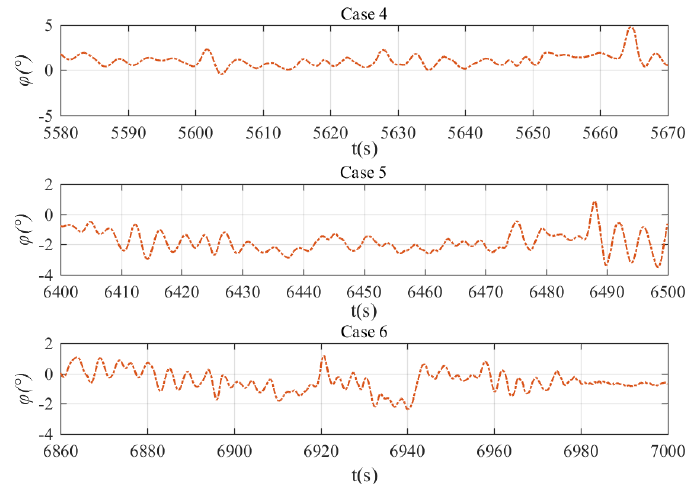
Figure 24. Roll angle during heading and depth control with rudder jam. Roll angle in case 4 (top), roll angle in case 5 (middle), and roll angle in case 6 (bottom).